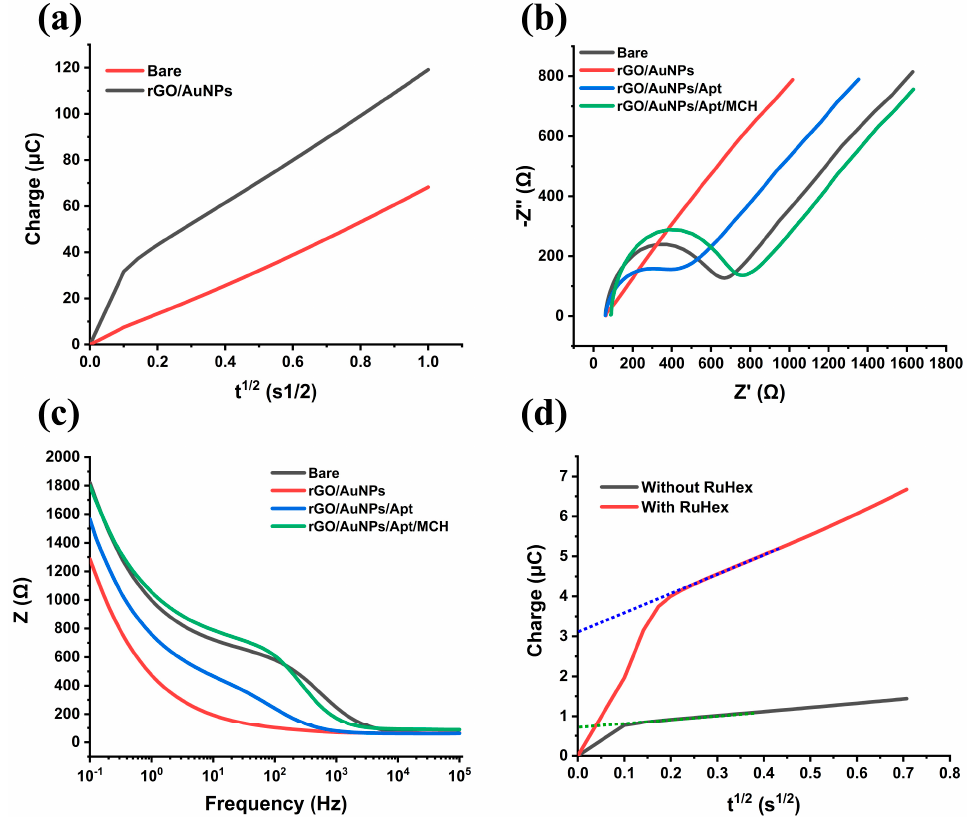
Figure 2. ( a ) CC responses of the bare electrode and rGO/AuNP modi fi ed electrode in 5 mM K 3 Fe(CN) 6 solution containing 0.1 M KCl; ( b ) the Nyquist plot and ( c ) Bode plot of the bare electrode and rGO/AuNP modified electrode in 5 mM K 3 Fe(CN) 6 /K 4 Fe(CN) 6 mixture; ( d ) CC responses of the aptasensor in the absence and presence of 50 µM RuHex.